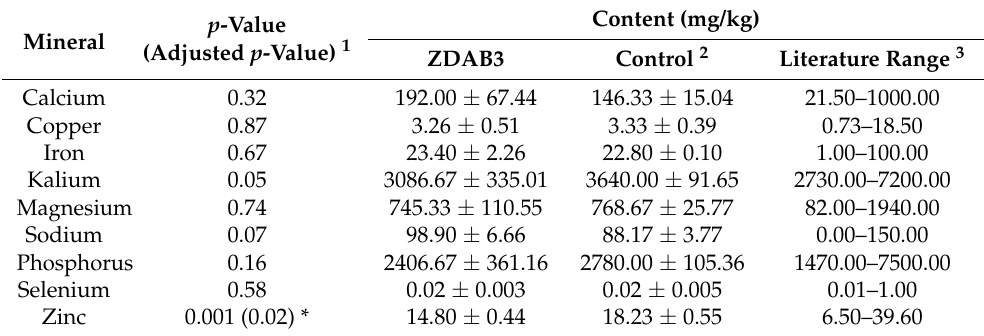
Table 7. Mineral values in maize samples.